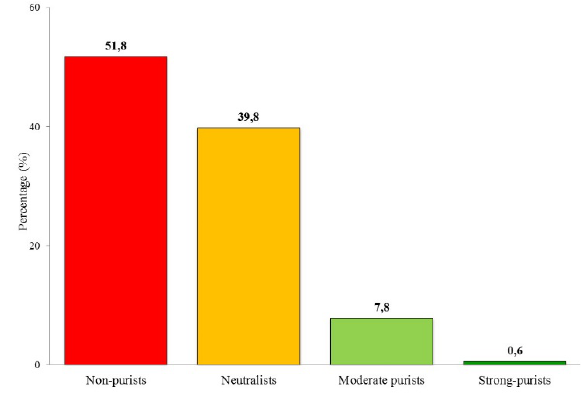
Figure 14. Icelanders categorized according to the purism scale.